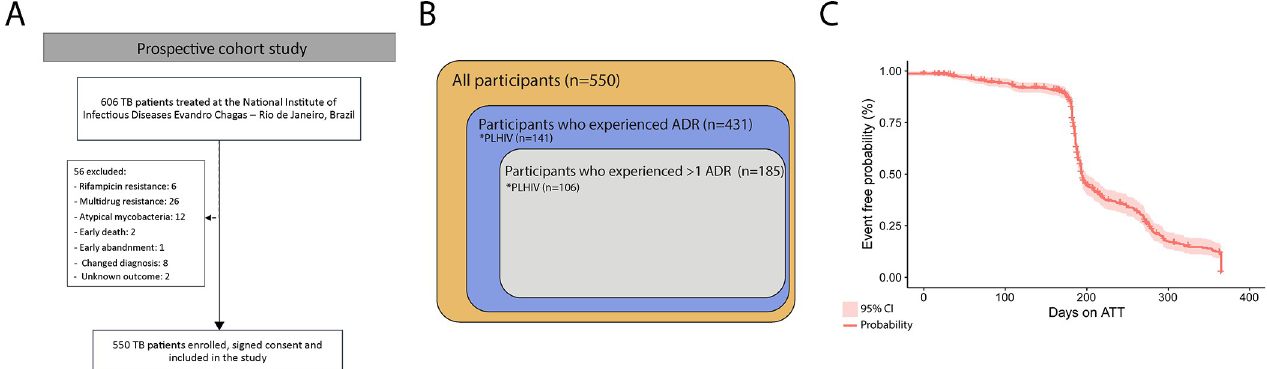
Fig 1. Study design and probability of presenting adverse drug reactions during the antitubercular treatment. (A) Study design. (B) Event free curve (Kaplan-Meier) of tuberculosis patients during antitubercular treatment. Mean time (in state, restricted max time = 365) in days of event occurrence: 140.7. Abbreviation: ADR: adverse drug reaction; ATT: anti-TB treatment; CI: confidence interval; TB: